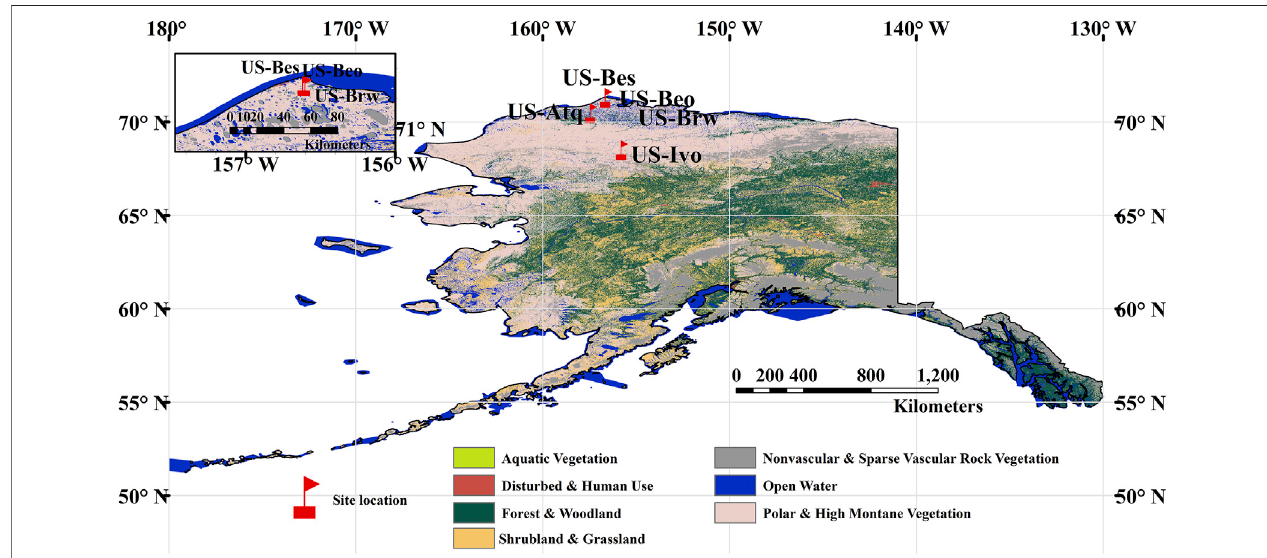
FIGURE 1 | The land cover in Alaskan region and an inset showing the location of the eddy covariance tower sites and National Oceanic and Atmospheric Administration(NOAA) BRWstationinAlaska.ThelandcoverinAlaskanregionwasfromGAP/LANDFIRENationalTerrestrialEcosystemsdataforU.S.and providedby the United States Geological Survey (https://www.usgs.gov/). The US-Brw, US-Bes,and US-Beoareoverlapped asthree sites areclose in distance; two-site labels are shown in the inset.